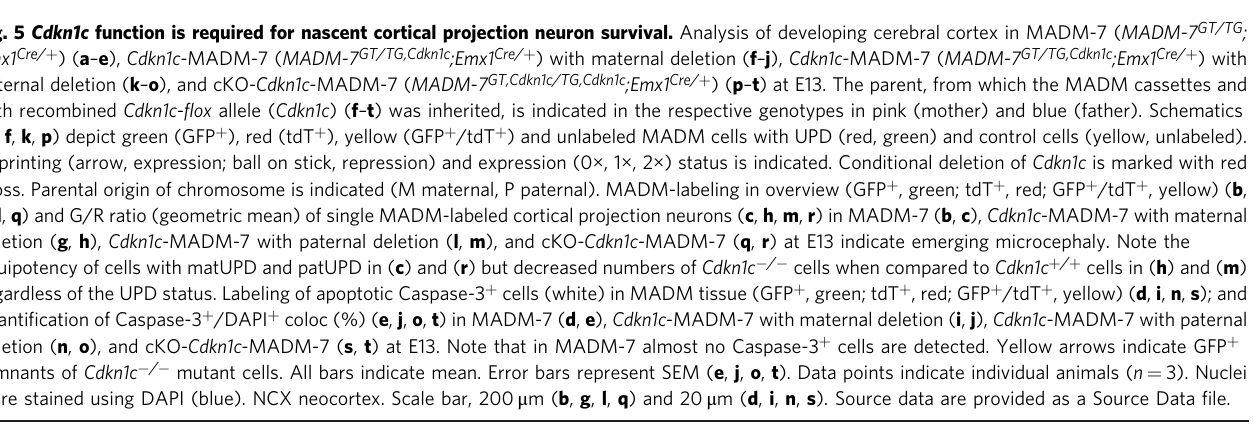
Fig. 5 Cdkn1c function is required for nascent cortical projection neuron survival. Analysis of developing cerebral cortex in MADM-7 ( MADM-7 GT/TG ; Emx1 Cre/ + ) ( a – e ), Cdkn1c -MADM-7 ( MADM-7 GT/TG,Cdkn1c ;Emx1 Cre/ + ) with maternal deletion ( f – j ), Cdkn1c -MADM-7 ( MADM-7 GT/TG,Cdkn1c ;Emx1 Cre/ + ) with paternal deletion ( k – o ), and cKO- Cdkn1c -MADM-7 ( MADM-7 GT,Cdkn1c/TG,Cdkn1c ;Emx1 Cre/ + ) ( p – t ) at E13. The parent, from which the MADM cassettes and with recombined Cdkn1c- fl ox allele ( Cdkn1c ) ( f – t ) was inherited, is indicated in the respective genotypes in pink (mother) and blue (father). Schematics ( a , f , k , p ) depict green (GFP + ), red (tdT + ), yellow (GFP + /tdT + ) and unlabeled MADM cells with UPD (red, green) and control cells (yellow, unlabeled). Imprinting (arrow, expression; ball on stick, repression) and expression (0×, 1×, 2×) status is indicated. Conditional deletion of Cdkn1c is marked with red cross. Parental origin of chromosome is indicated (M maternal, P paternal). MADM-labeling in overview (GFP + , green; tdT + , red; GFP + /tdT + , yellow) ( b , g , l , q ) and G/R ratio (geometric mean) of single MADM-labeled cortical projection neurons ( c , h , m , r ) in MADM-7 ( b , c ), Cdkn1c -MADM-7 with maternal deletion ( g , h ), Cdkn1c -MADM-7 with paternal deletion ( l , m ), and cKO- Cdkn1c -MADM-7 ( q , r ) at E13 indicate emerging microcephaly. Note the equipotency of cells with matUPD and patUPD in ( c ) and ( r ) but decreased numbers of Cdkn1c − / − cells when compared to Cdkn1c + / + cells in ( h ) and ( m ) regardless of the UPD status. Labeling of apoptotic Caspase-3 + cells (white) in MADM tissue (GFP + , green; tdT + , red; GFP + /tdT + , yellow) ( d , i , n , s ); and quanti fi cation of Caspase-3 + /DAPI + coloc (%) ( e , j , o , t ) in MADM-7 ( d , e ), Cdkn1c -MADM-7 with maternal deletion ( i , j ), Cdkn1c -MADM-7 with paternal deletion ( n , o ), and cKO- Cdkn1c -MADM-7 ( s , t ) at E13. Note that in MADM-7 almost no Caspase-3 + cells are detected. Yellow arrows indicate GFP + remnants of Cdkn1c − / − mutant cells. All bars indicate mean. Error bars represent SEM ( e , j , o , t ). Data points indicate individual animals ( n = 3).